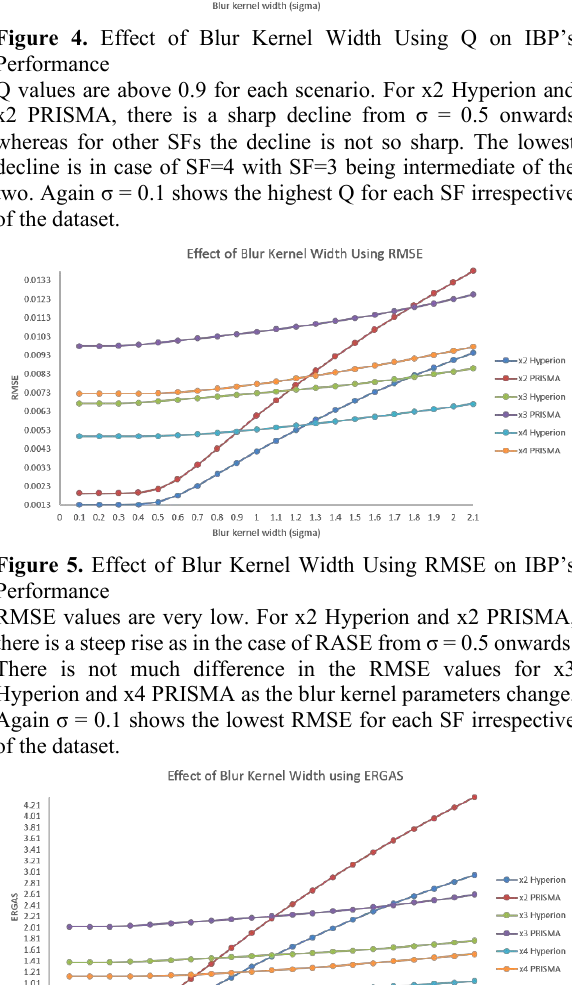
Figure 9. Effect of Blur Kernel Width Using DIV on IBP’s Performance DIV values are positive, increasing with rising kernel size and σ. The sharpest rise is in the case of x2 PRISMA from σ = 0.5 onwards. For x3 PRISMA the rise in values begins from σ = 0.4. x3 Hyperion and x4 PRISMA almost overlap each other with rising kernel size and σ. Again σ = 0.1 shows the lowest DIV for each SF irrespective of the